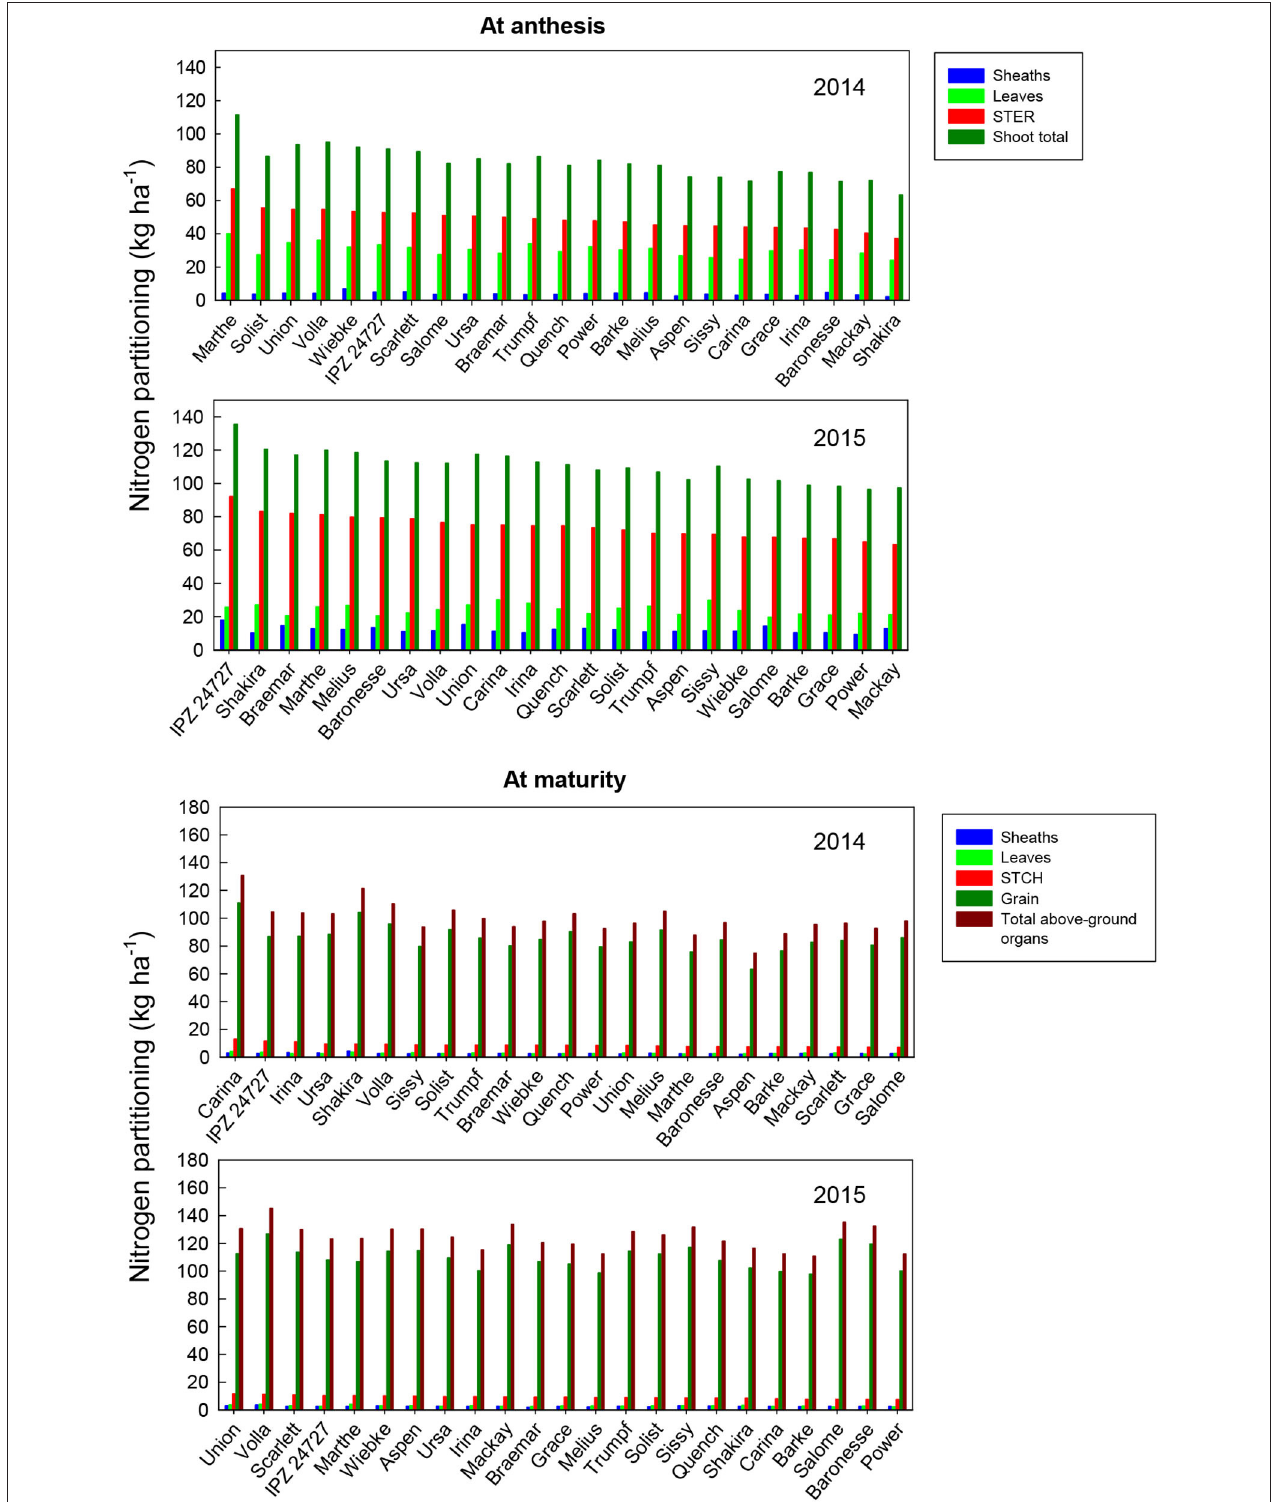
FIGURE 4 | Nitrogen partitioning in different organs: N accumulation (kg ha − 1 ) of different plant organs of the 23 spring malting barley varieties at anthesis and maturity under recommended N fertilization conditions in 2014 and 2015, ranked on STER N at anthesis or STCH N at maturity. Mean comparisons among the varieties from Tukey’s HSD test are shown in Supplementary Tables 5 and 7